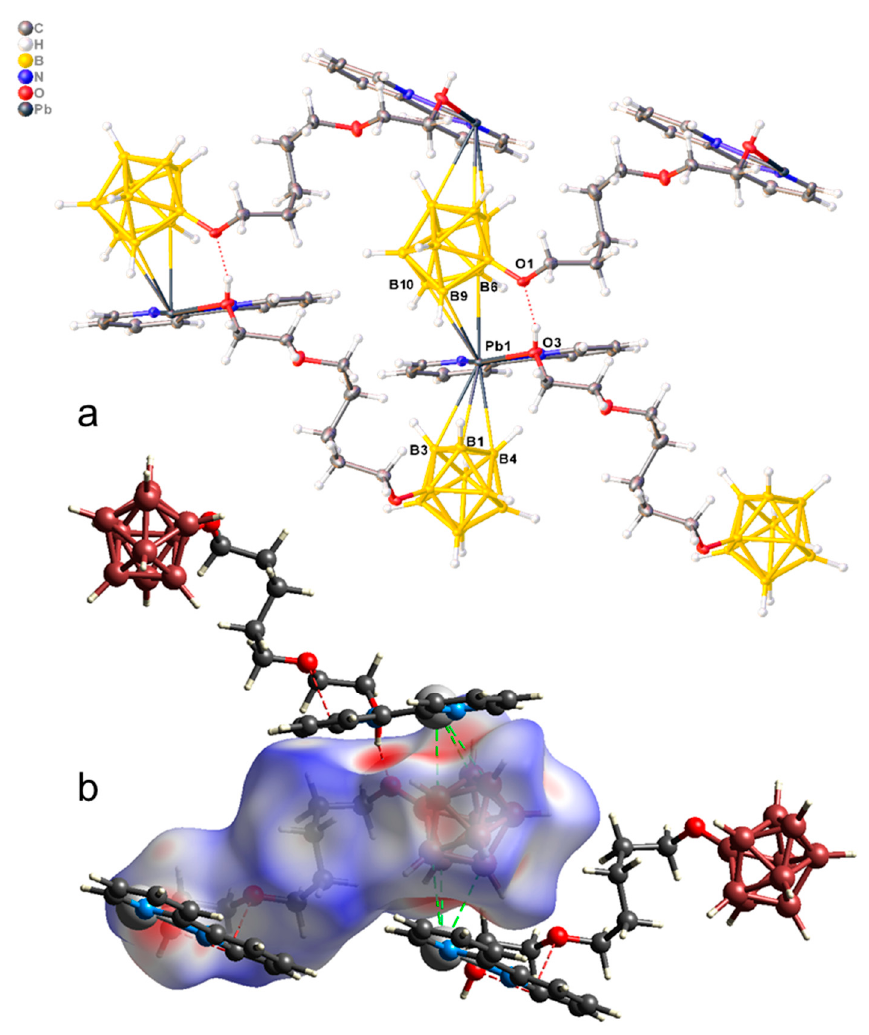
Figure 5. ( a ) Structure of polymeric complex 3 ; ( b ) Hirschfeld surface of the [B 10 H 9 O(CH 2 ) 5 O(CH 2 ) 2 OH] 2 − anion in complex 3 . Table 3. Metal–heteroatom distances in complex 3 . Bond Distance, Å